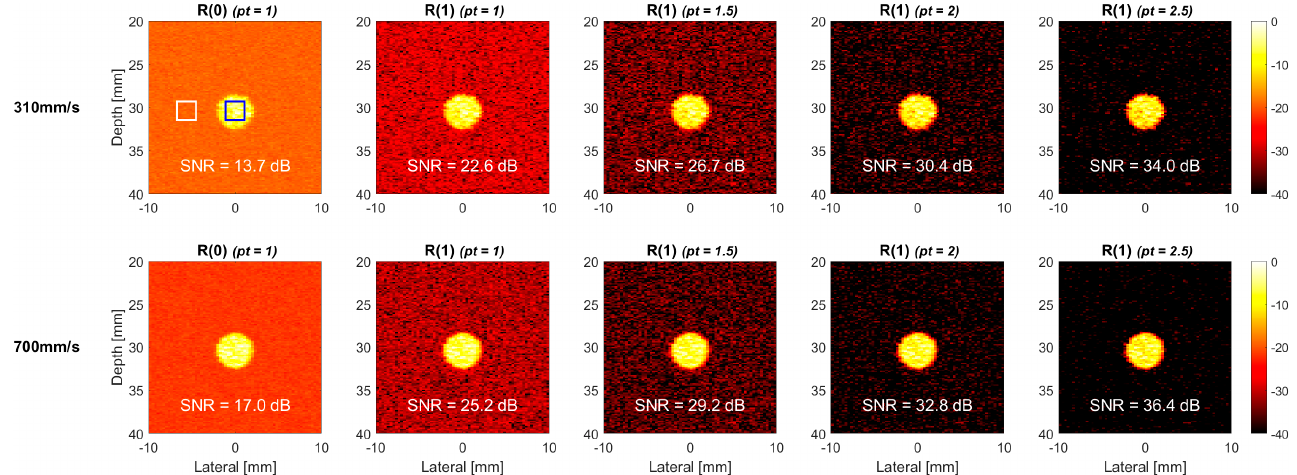
Figure 8. Simulated TMAS power Doppler images of cross-view flow phantom for R(1) images with the pt values of 1.0, 1.5, 2.0 and 2.5, respectively from left to right. R(0) image is also provided as a reference. The flow velocity is 310 mm/s ( upper ) and 700 mm/s ( lower ). The inclined angle of the flow vessel is 0°.